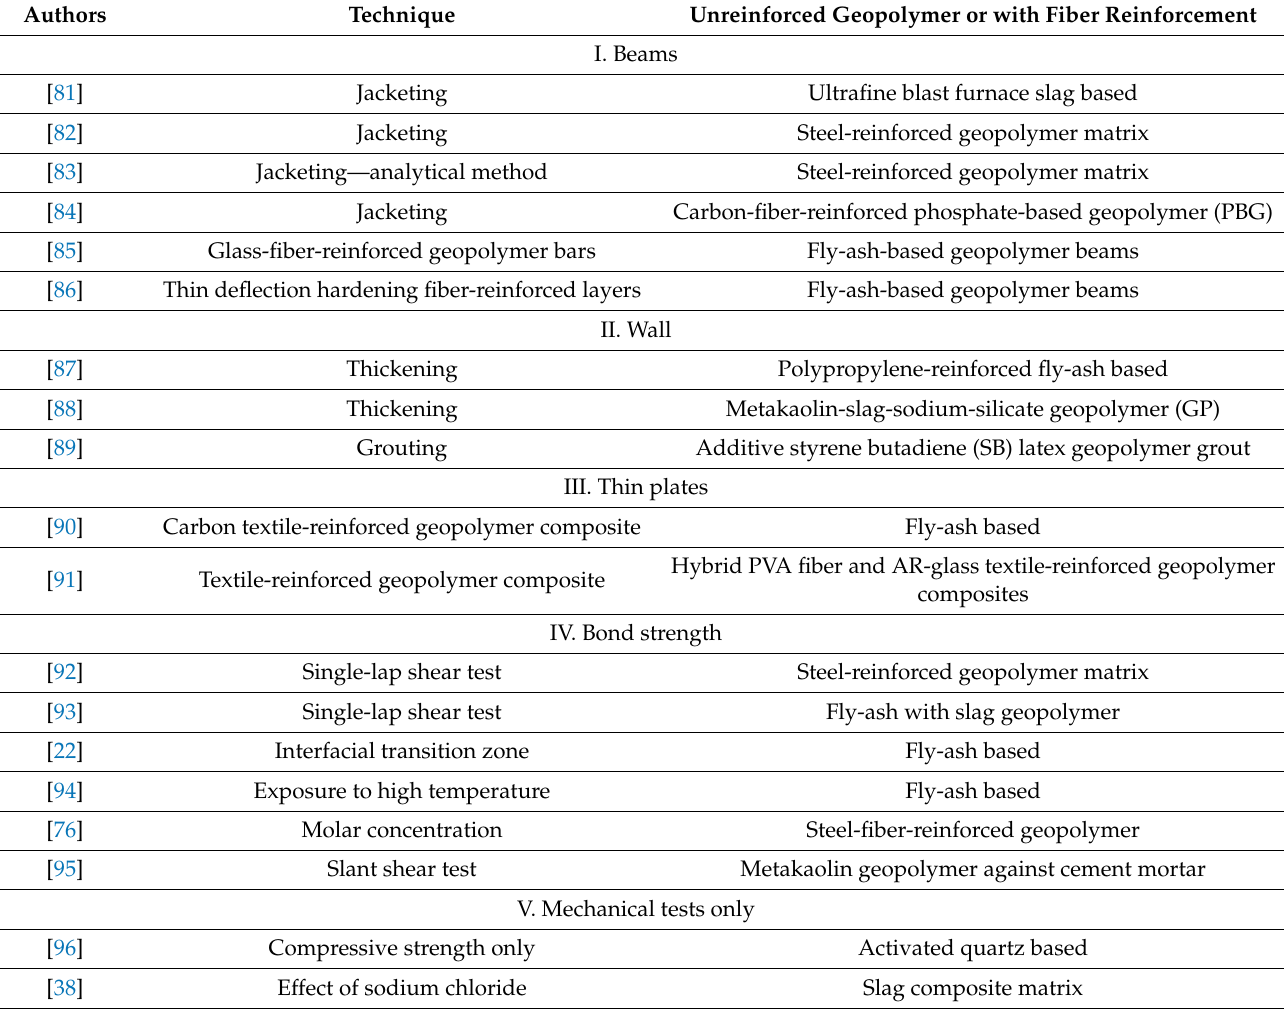
Table 3. Summary of studies on geopolymers used as a strengthening